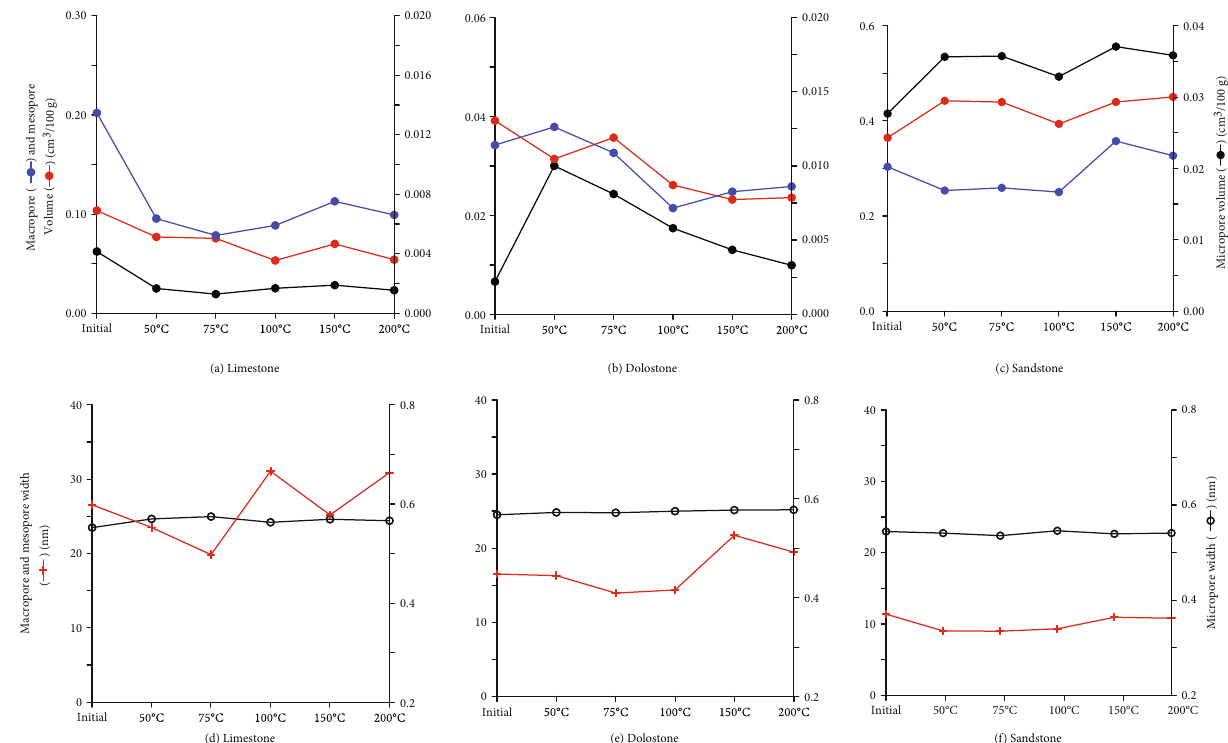
Figure 8: Evolution of pore volume ((a) limestone series, (b) dolostone series, and (c) sandstone series) and pore width ((d) limestone series, (e) dolostone series, and (f) sandstone series) of initial and altered rock grains from the simulation. “ Initial ” describes initial rock grains. Blue, red, and black- fi lled circles show the volumes of macropores, mesopores, and micropores, respectively. Red crosses show the average widths of macropores and mesopores. Hollow circles show the median widths of micropores. Note that numerical scales di ff er among the y -axes in (a) –